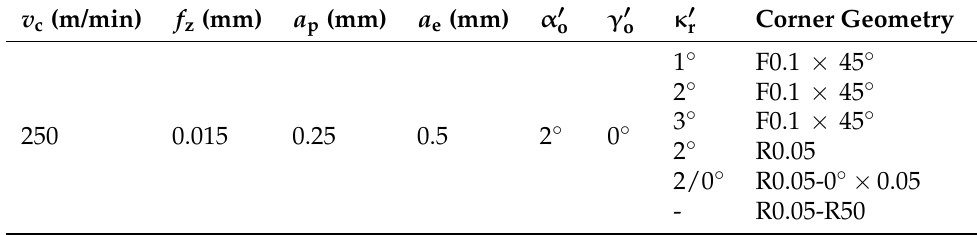
Table 2. Cutting parameters and tool geometries investigated in the experimental